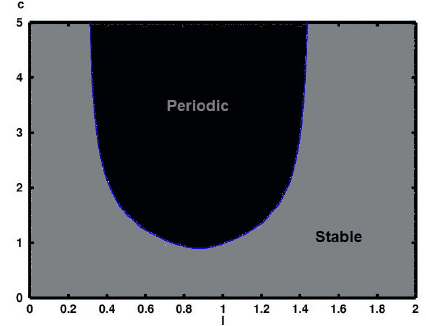
Figure 45. Two-parameter bifurcation of parameter c concerning the external applied current with parameters a = 0.8 , b = 0.7 & c = 3